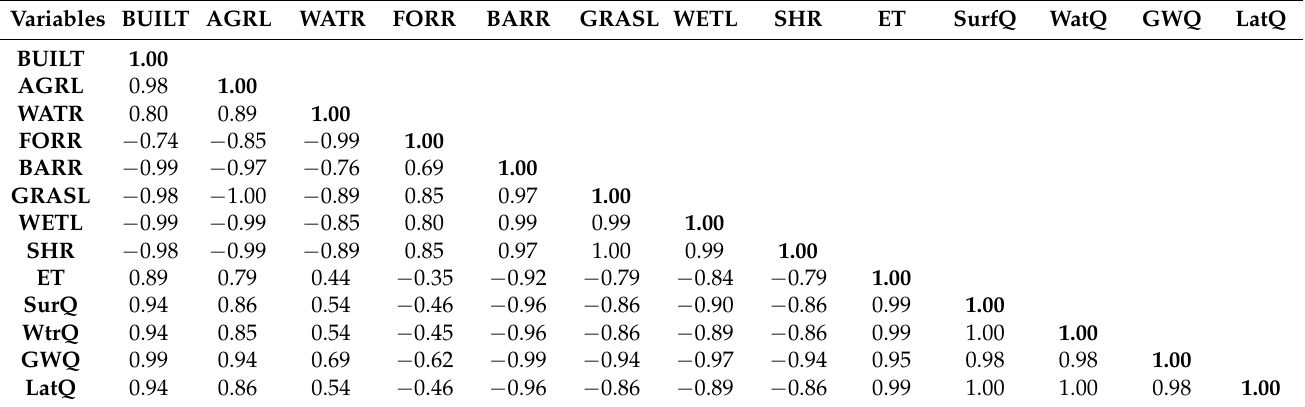
Table 6. Correlation matrix for the LC variables and selected hydrologic components.